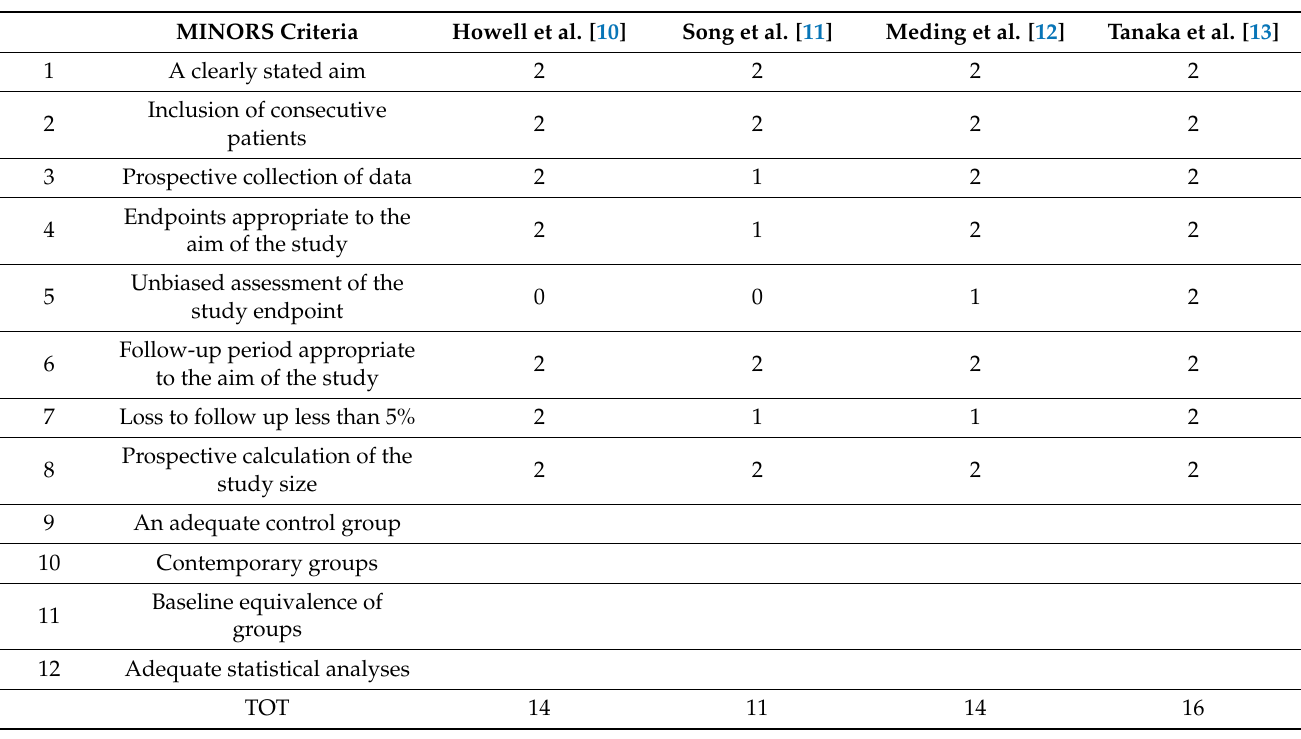
Table 1. Individual MINORS